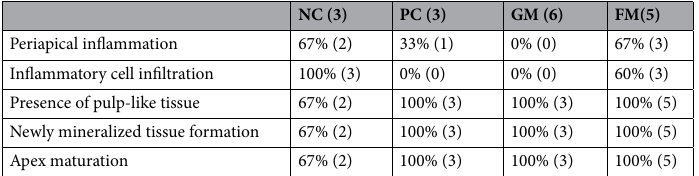
Table 3. Histologic outcomes of the experimental groups after 12 weeks. NC negative control, PC positive control, GM gelatin-based matrix, FM fibrin-based